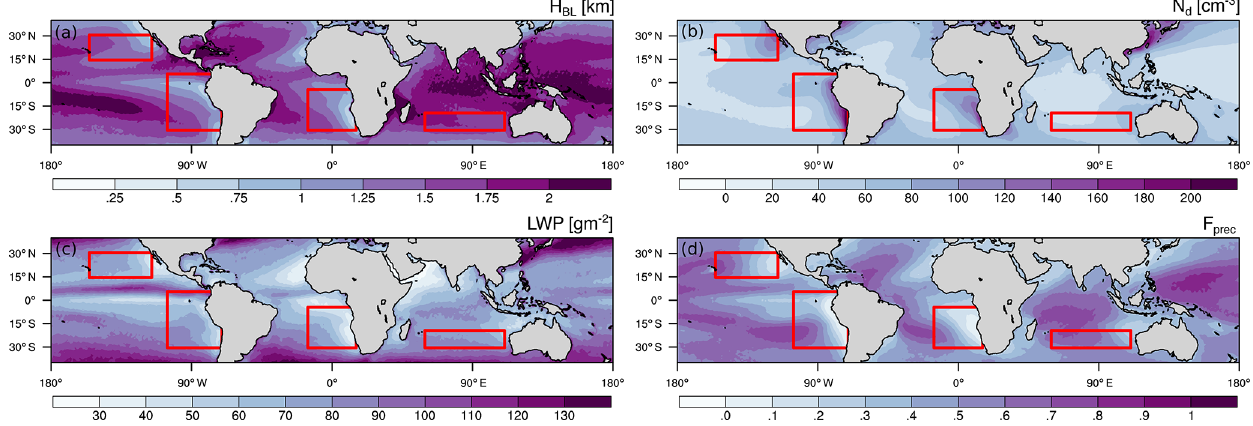
Figure 2. (a) Boundary layer height ( H BL ), (b) cloud droplet number concentration ( N d ), (c) liquid water path (LWP), and (d) low-cloud precipitation probability ( F prec ) are shown. Regions of subtropical stratocumulus decks are marked in red and were defined in Eastman and Wood (2016) based on surface observations of Hahn and Warren